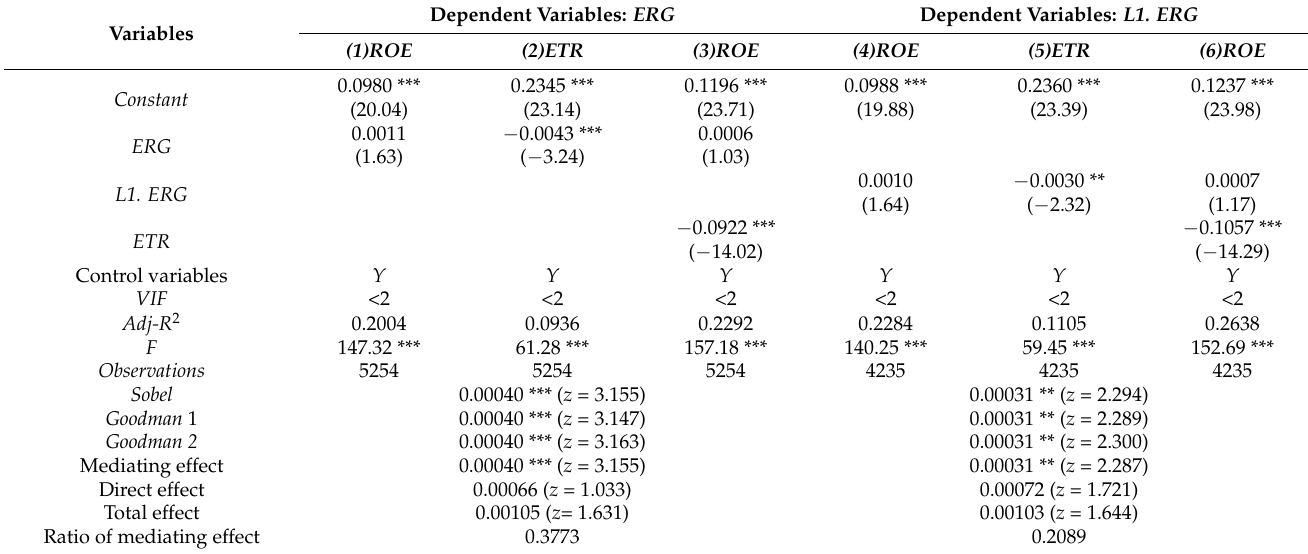
Table 10. Robustness testing of different measurement indicators (current period and lag phase I).